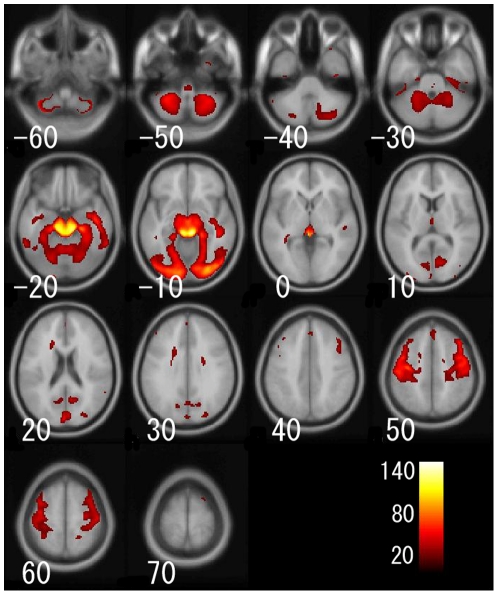
Gray matter regions that showed a significant age × gender interaction on regional gray matter volume.Details are the same as in Figure 4.